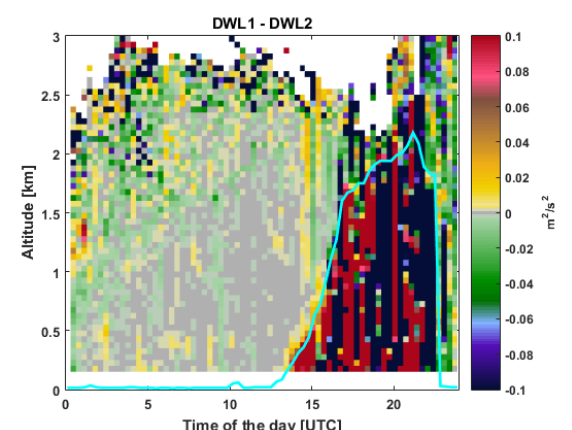
Figure 5: Time-height cross-section showing the difference in vertical velocity variance between two sites on 26 September 2017. The cyan solid like represent mixing layer height measured by